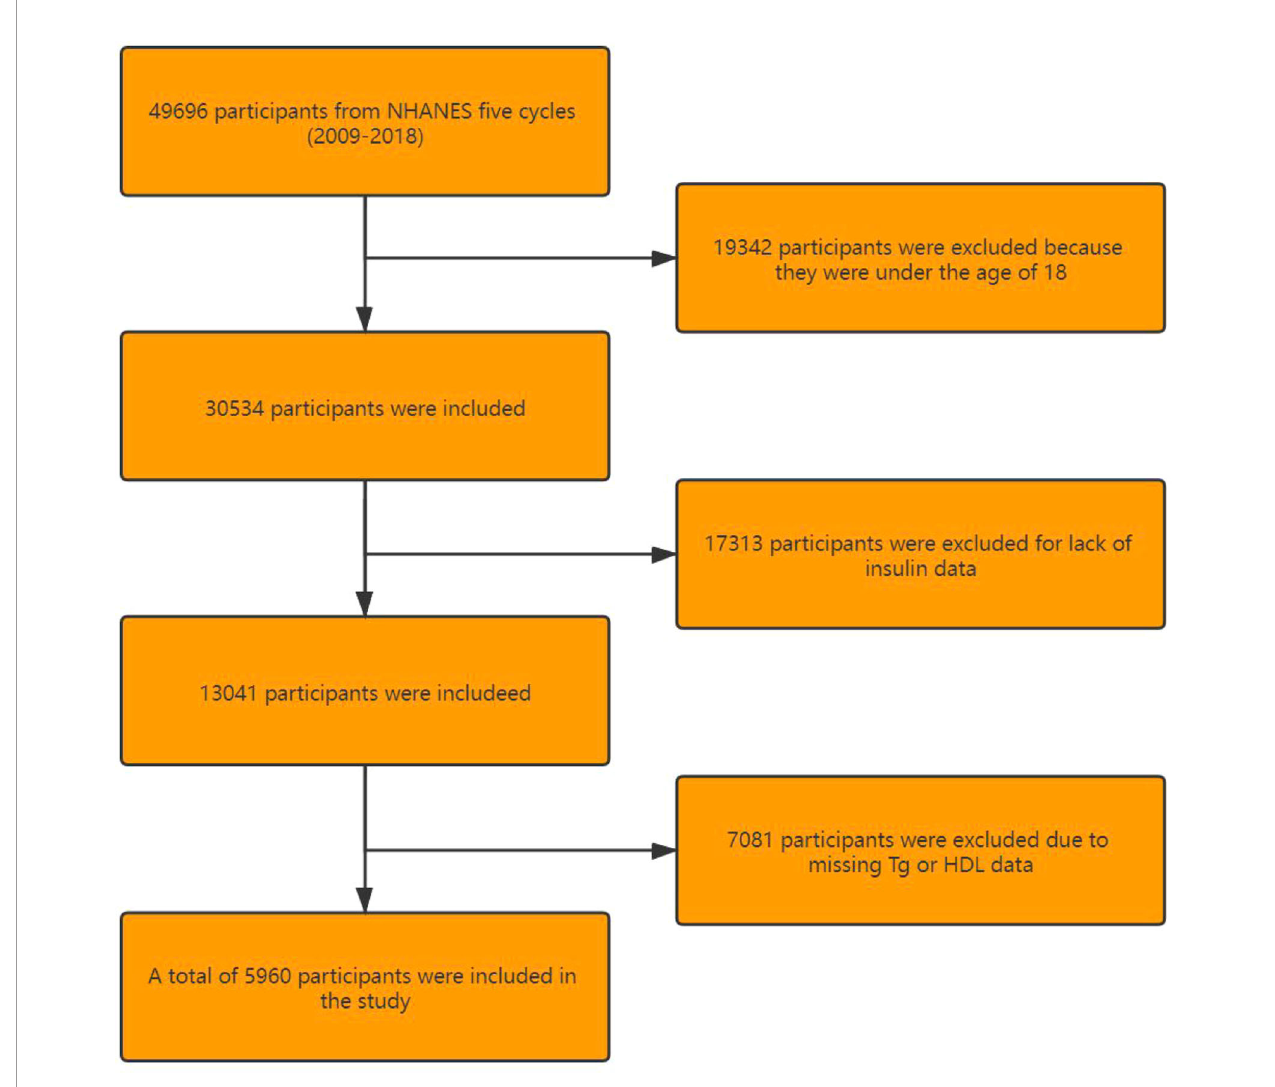
FIGURE 1 | Flowchart of participant